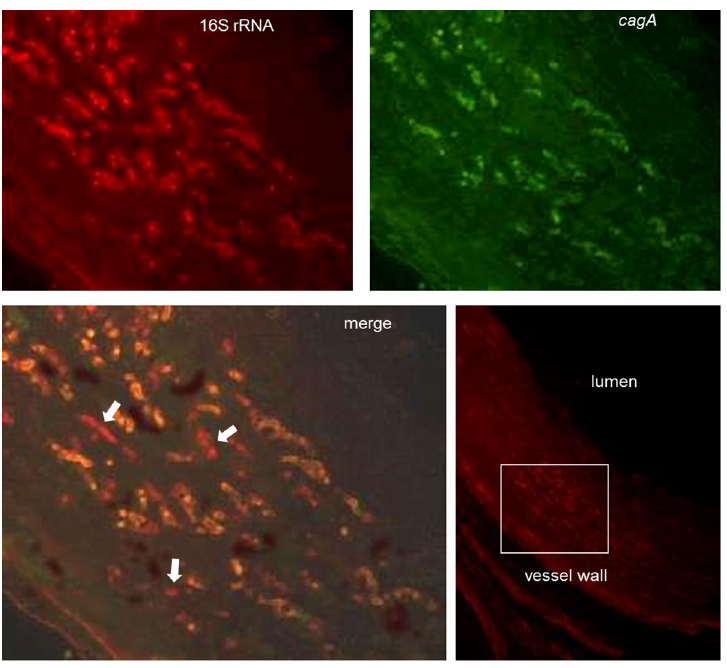
Fig 5. Fluorescence in situ hybridization on an artery section demonstrating mixed cagA -positive and cagA - negative H . pylori . Fluorescence in situ hybridization of H . pylori 16S rRNA (red) and cagA (green) was conducted on tissue sections and imaged using confocal microscopy. White arrows indicate H . pylori lacking cagA expression. The bottom right panel shows the region of interest (white box) in a lower magnification image.